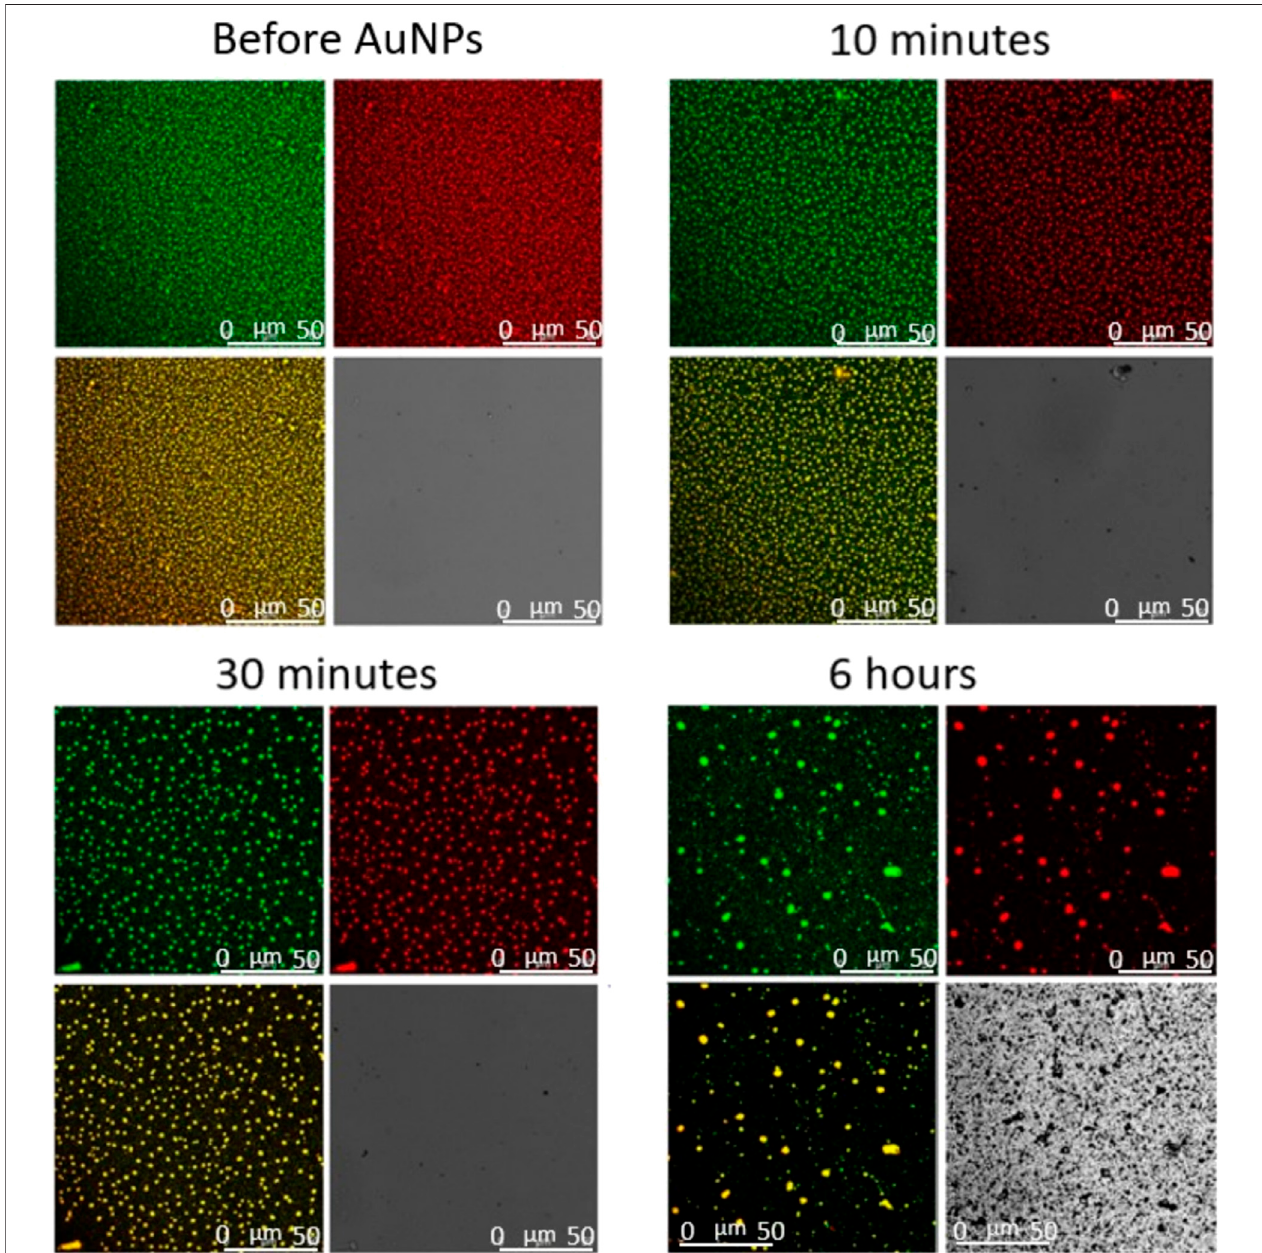
FIGURE6| Representative2DConfocalMicroscopyimagesoftheinteractionofAuNPs0.83 nMwiththe fi lmofcubosomesdepositedontheDOPC/DOTAPSLB. Images collected at different incubation times (before and after 10 min, 30 min, and 6 h from AuNPs injection).